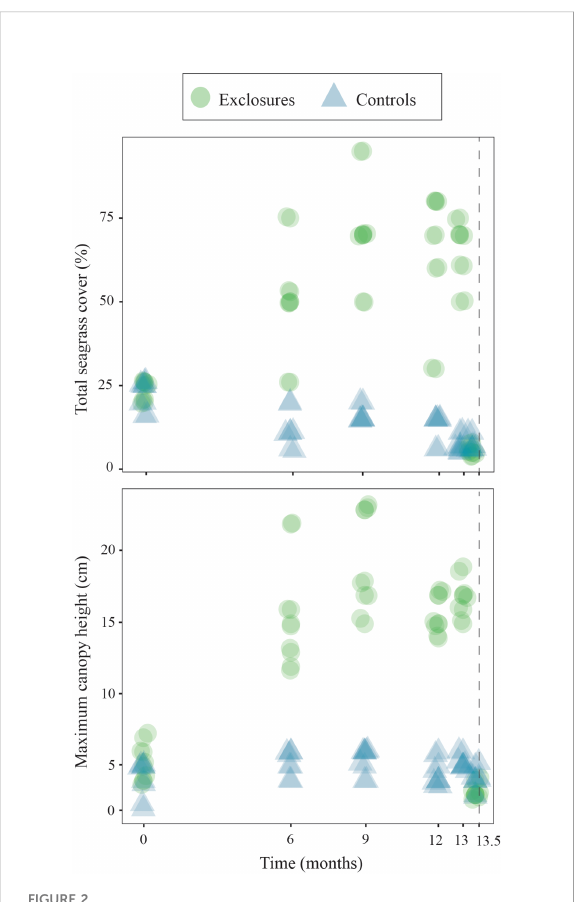
FIGURE 2 Total seagrass cover and maximum canopy height within exclosures and controls over 13 months of megaherbivore exclusion at Cahuita, southern Caribbean coast of Costa Rica. The dotted line marks an additional sampling two weeks after exclosures were removed. Results have been jittered for visualization